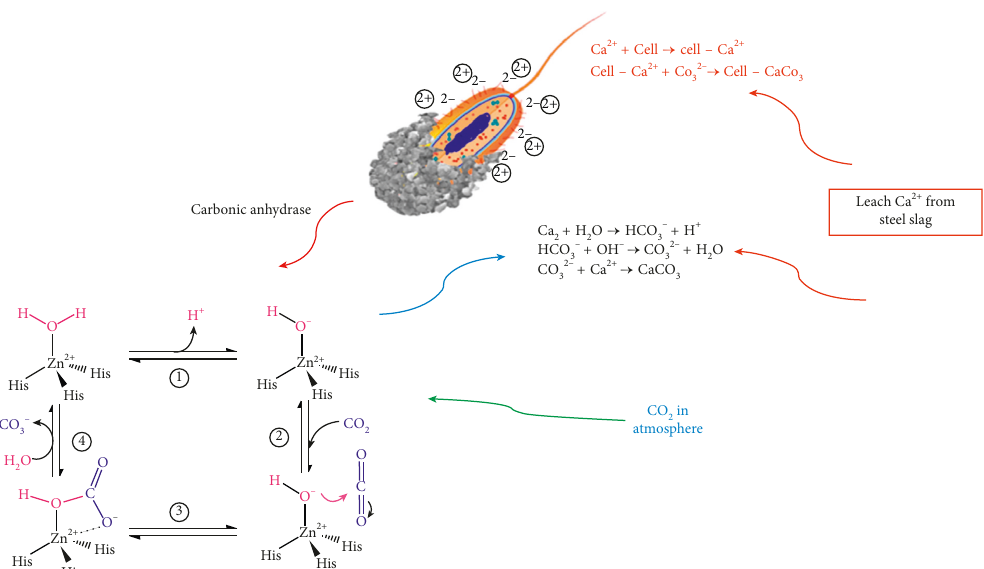
Figure 15: Formation process of biomineralization product in steel slag.